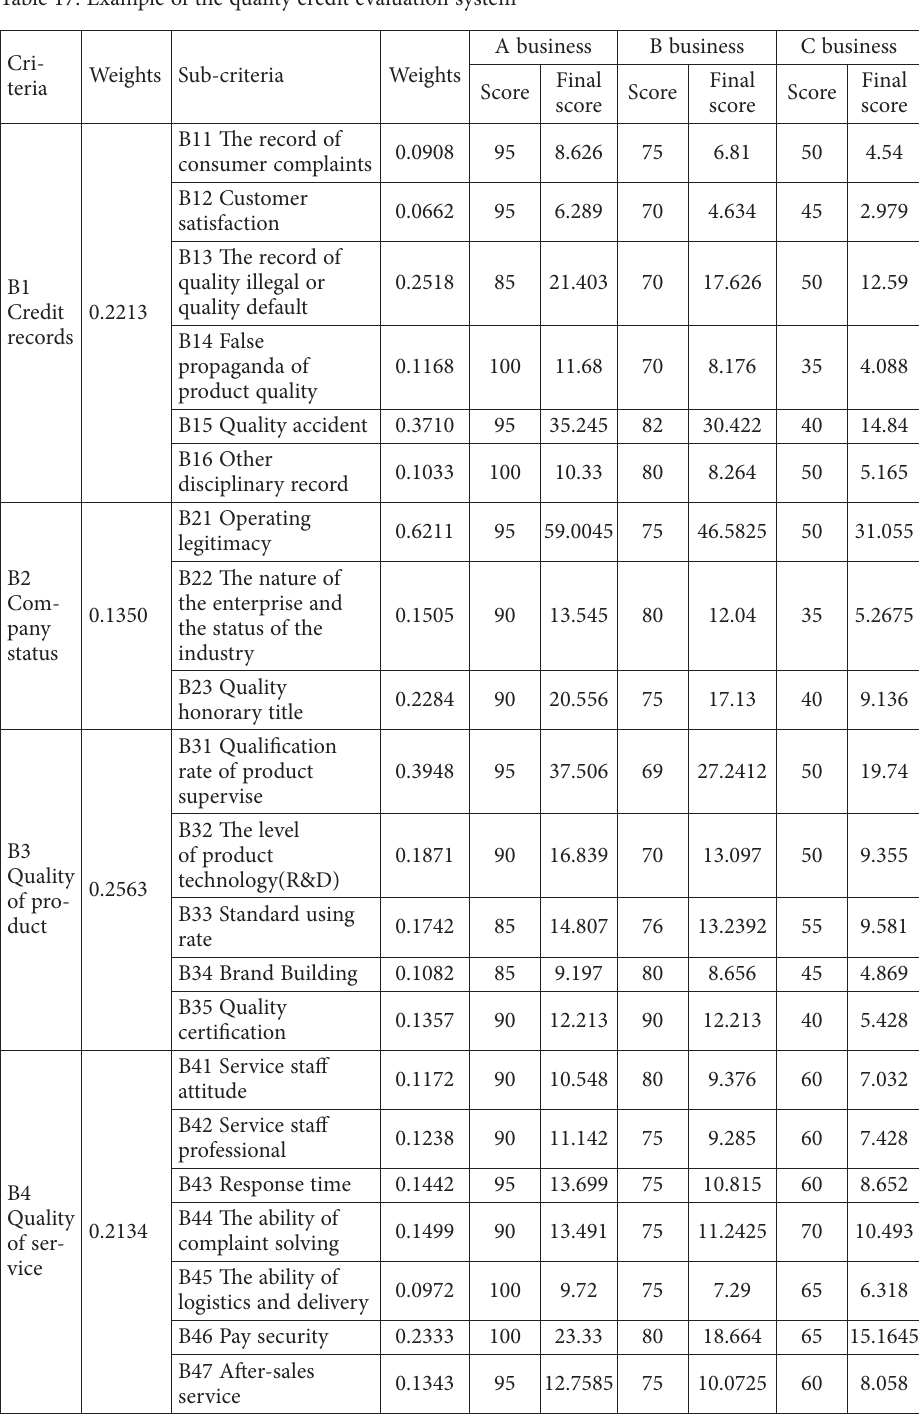
Table 17. Example of the quality credit evaluation system Cri- Weights teria